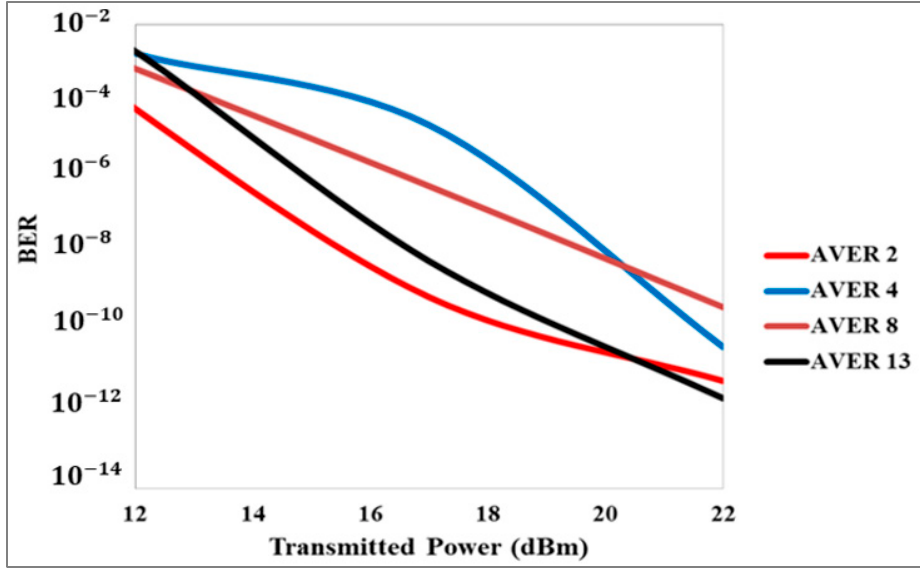
Figure 3. The Average BERs versus Transmitted Power for Four Random Channels (MDRZ).